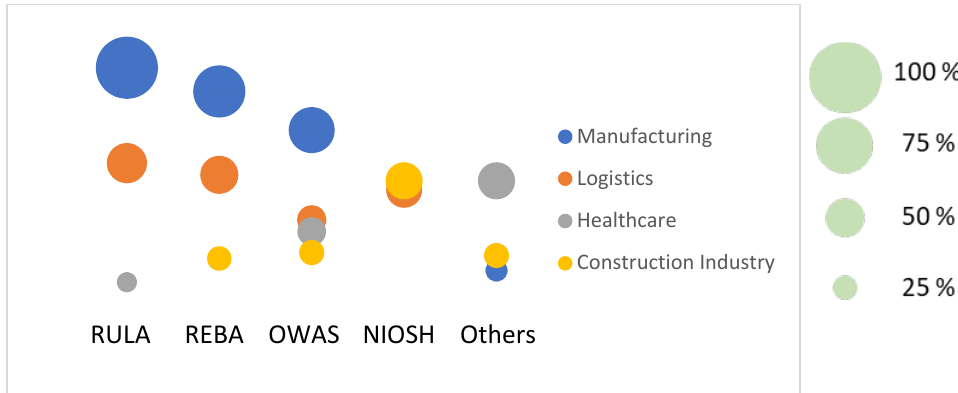
Figure 9. Comparison of used ergonomic methods percentage. Source: own processing.